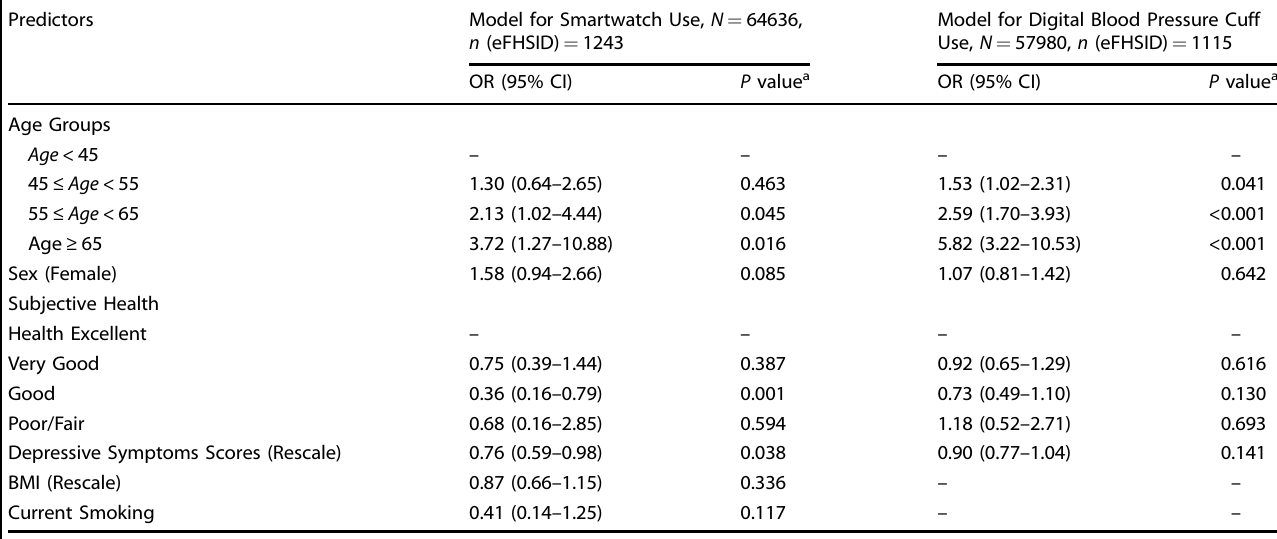
Table 3. Factors associated with digital device use: results of multivariable models.